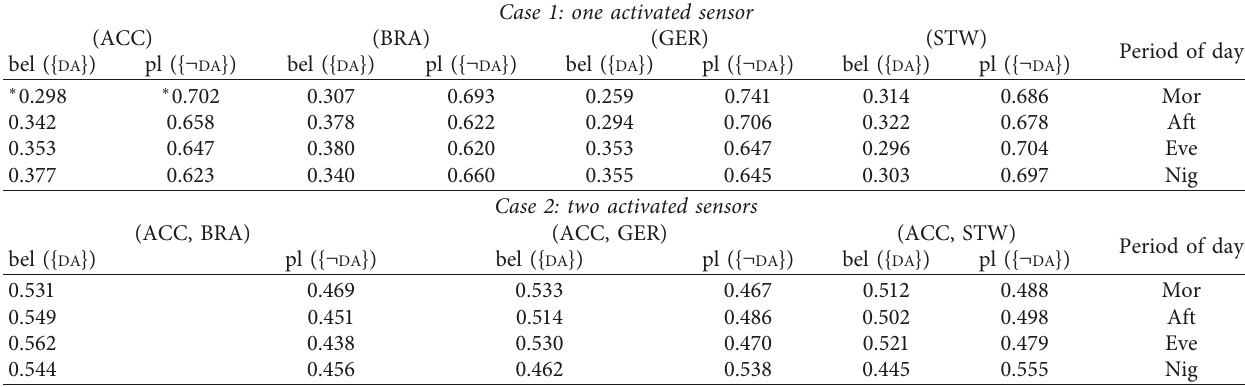
Table 3: Belief values of DA with a number of activated sensors in all periods of day.